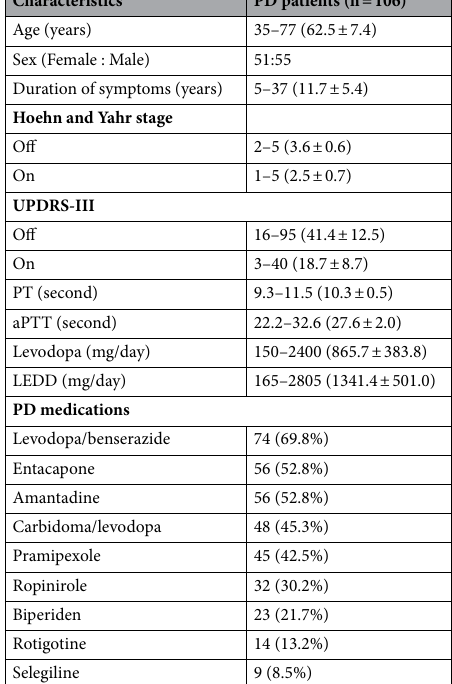
Table 1. Demography of patients with Parkinson’s disease. PD, Parkinson’s disease; UPDRS, Unified Parkinson’s Disease Rating Scale; PT, prothrombin time; aPTT, activated partial prothrombin time; LEDD, levodopa equivalent daily dose.